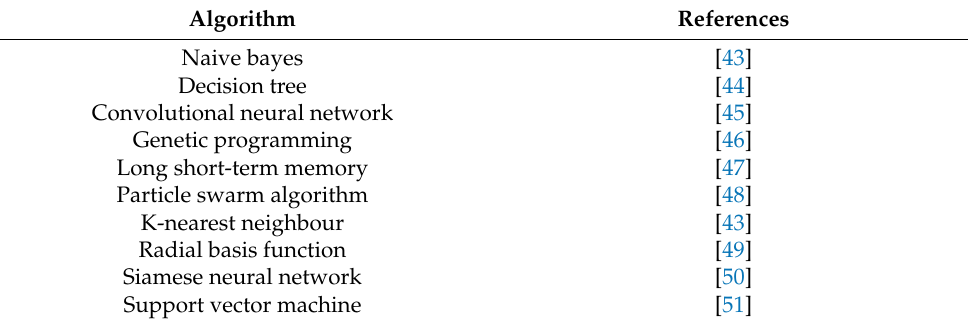
Table 1. Supervised machine-learning algorithms used in general 3D